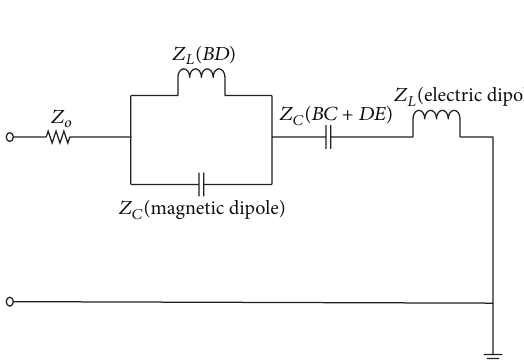
Figure 3: Equivalent circuit of ME dipole antenna.